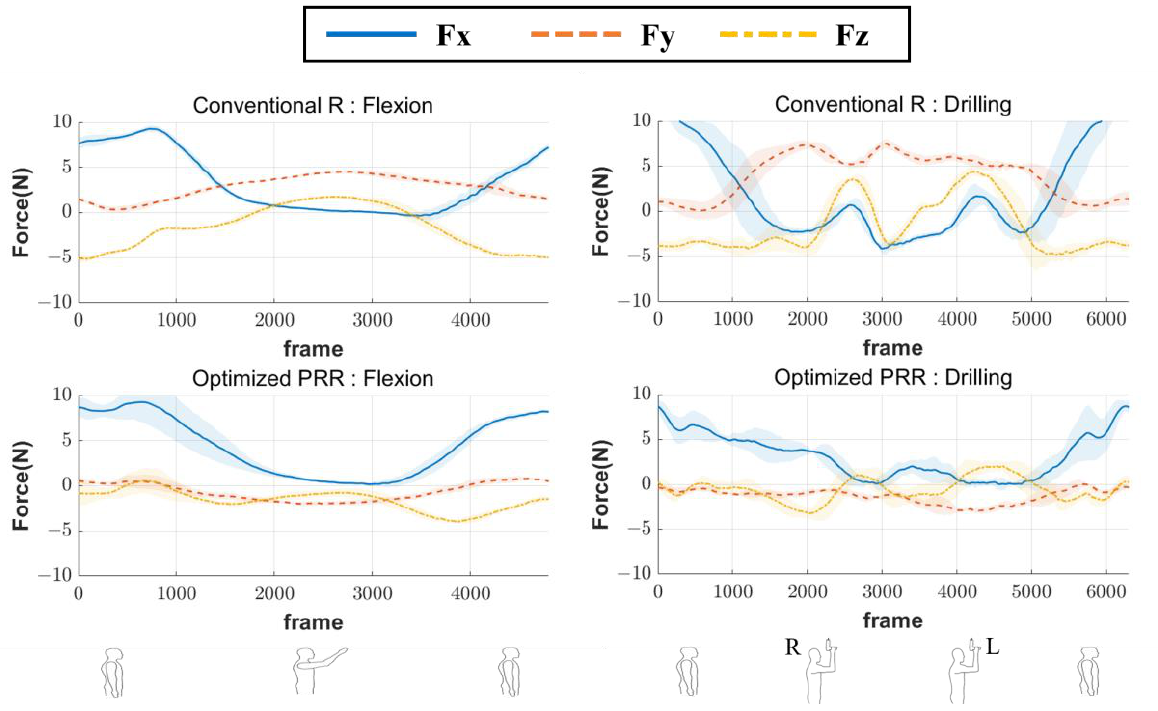
Figure 14. Variation in the triaxial interaction force during the entire cycle of flexion/extension and drilling motions. The sequence of drilling motion is as follows: static position → drilling the right point → drilling the left point → static position.